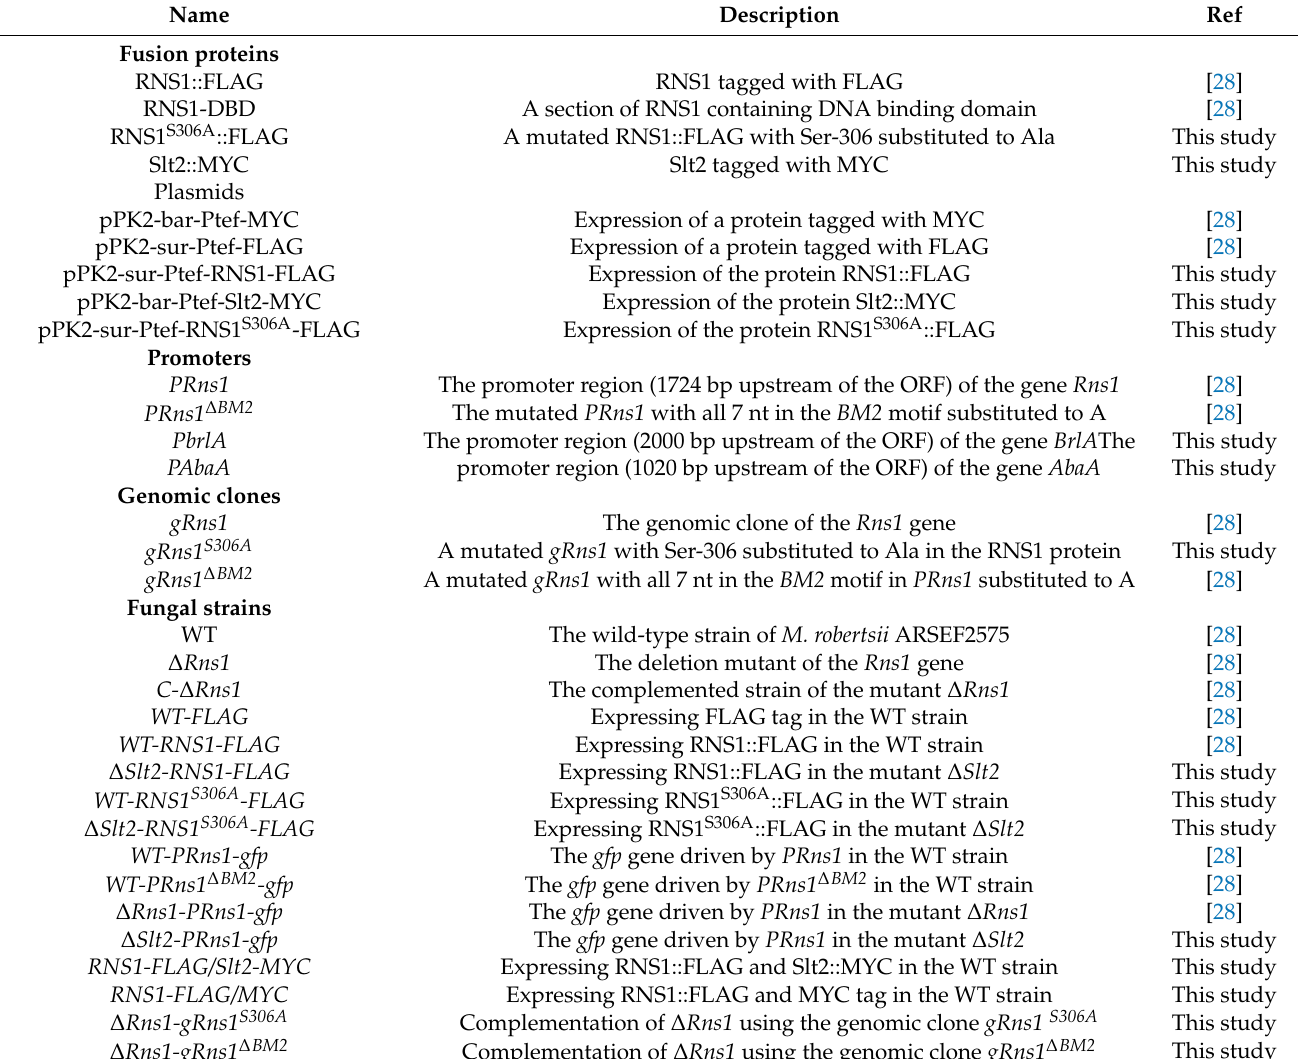
Table 1. Plasmids, fusion proteins and fungal strains used in this